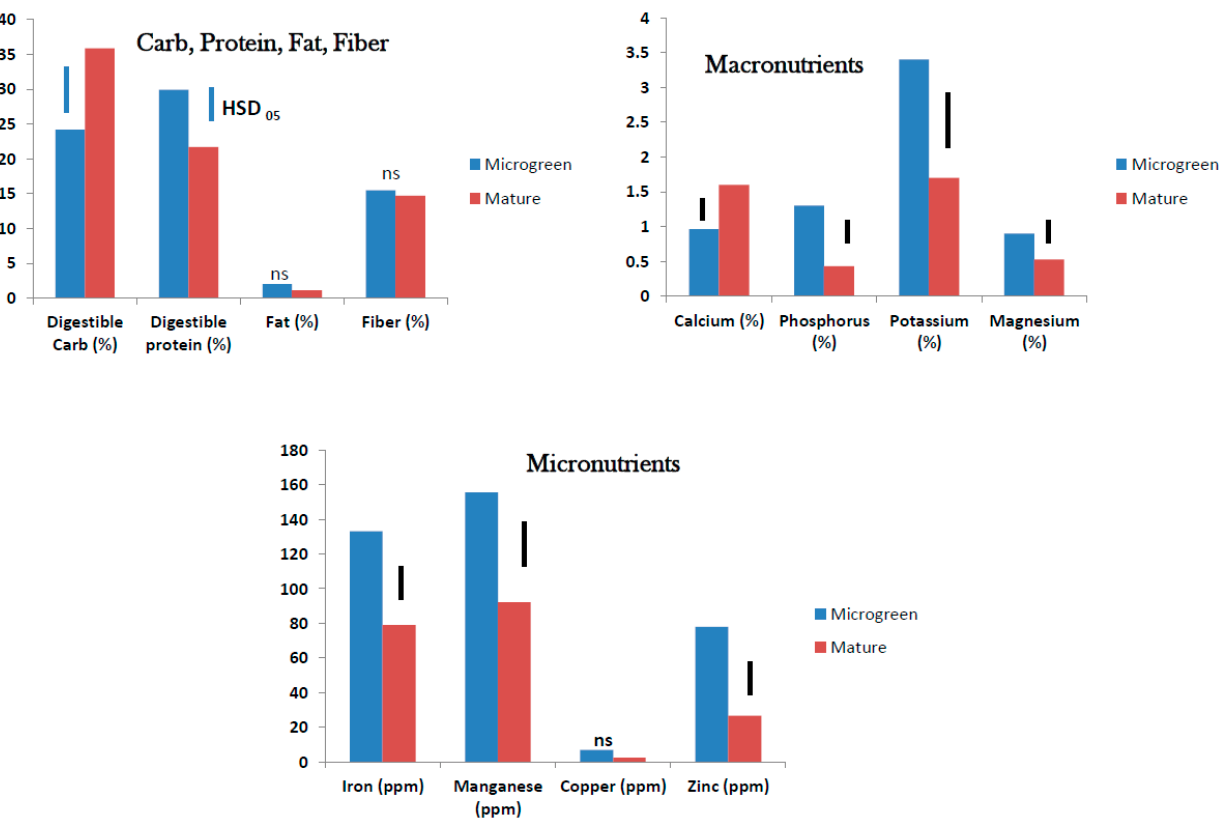
Figure 7. Nutrient status compared on dry weight basis between roselle micro/baby-green (average of 10–20 day-old seedlings) and mature plant (average of 7- and 9-week-old plants). (ns = no significant difference; bars show Tukey’s HSD at α = 0.05).